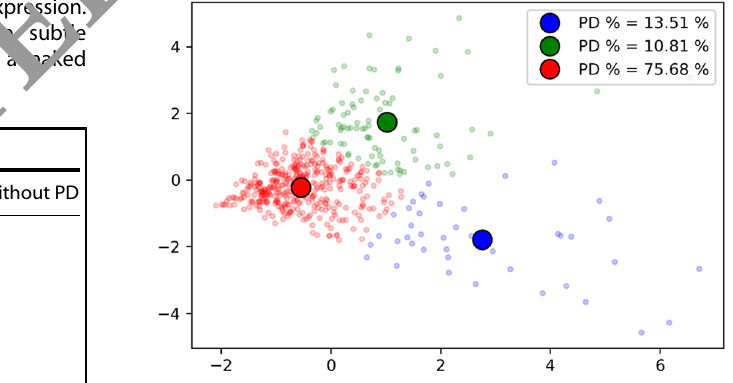
Fig. 1 Logistic regression weights of the features while predicting PD. The green color represents the features with p <